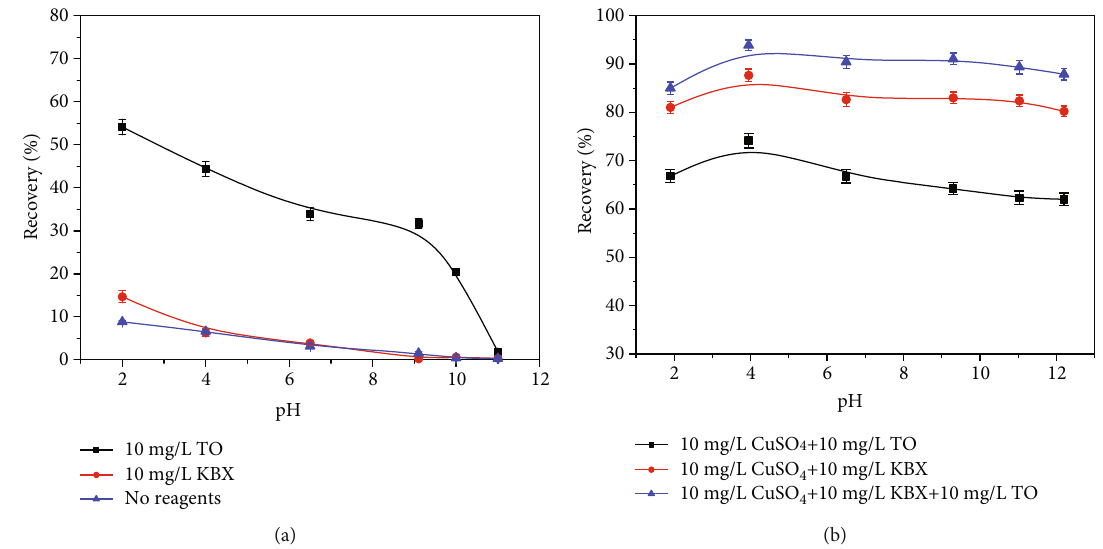
Figure 5: E ff ect of TO on the fl otation behavior of sphalerite: (a) without activation by CuSO